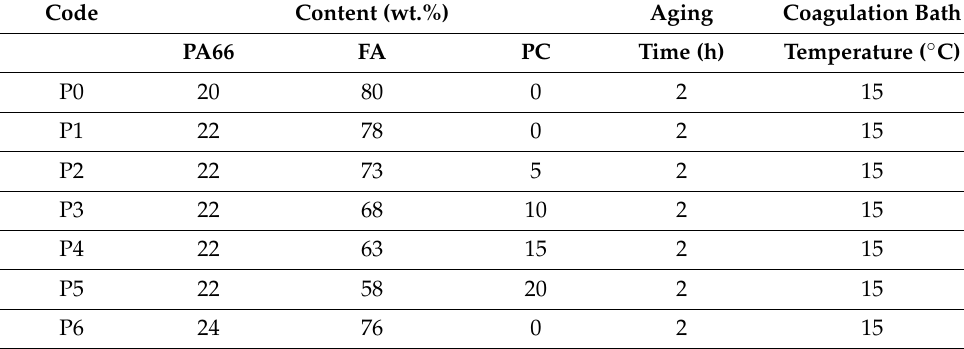
Table 1. Casting solution composition and preparation conditions of different